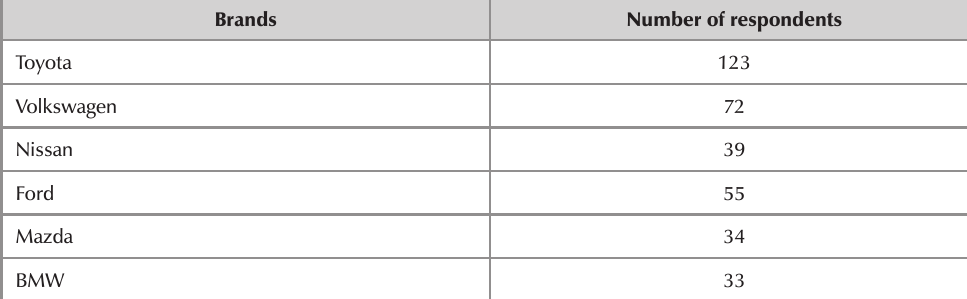
Number of respondents for best supported